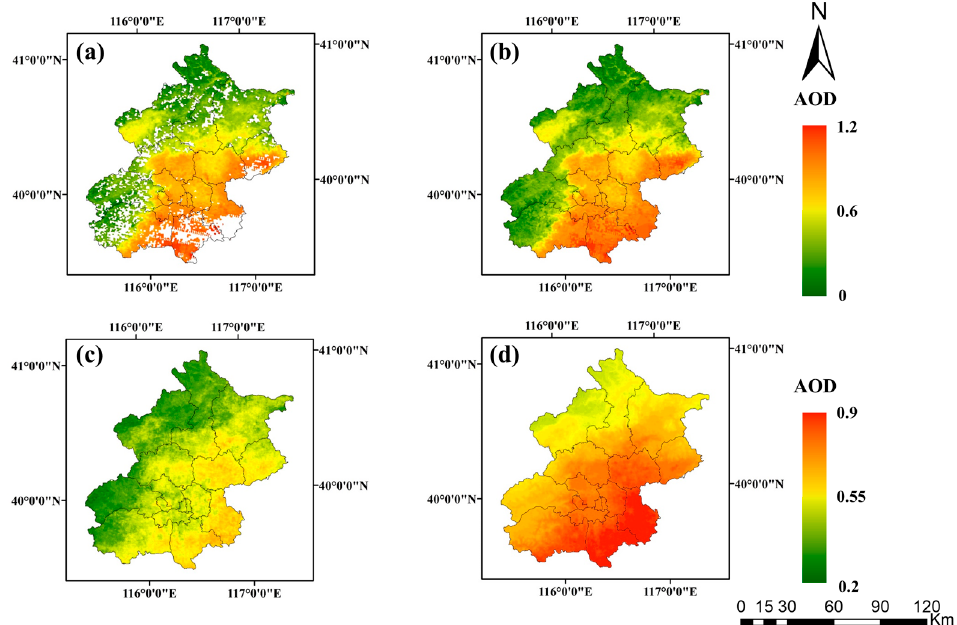
Figure 3. Difference between the cloud-removal SARA AOD ( a ) and the gap-filled SARA AOD ( b ) on 18 December 2016. Difference between the annually averaged distribution of the cloud-removal SARA AOD ( c ) and the gap-filled SARA AOD ( d ).